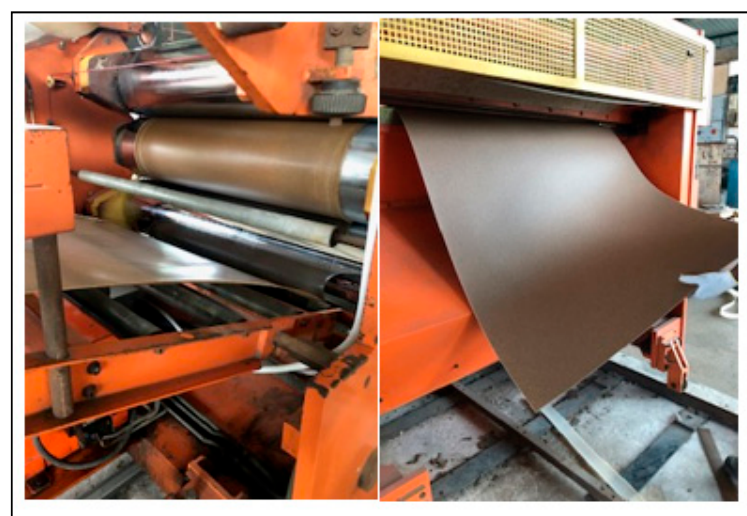
Figure 1. Sheet extrusion process.